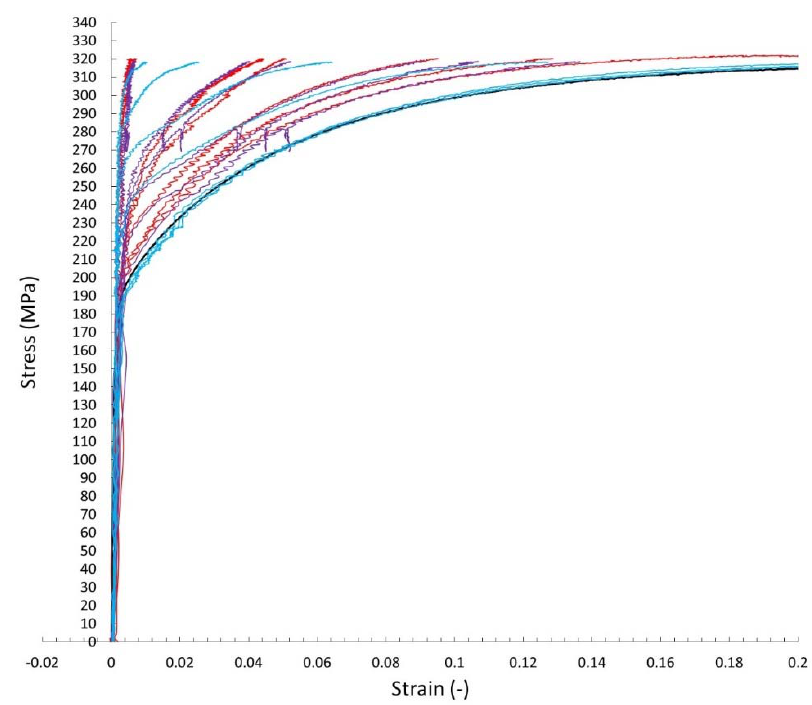
Figure 10. The curves of the static tensile test determined on the basis of the DIC method for welded joints made in robotic welding processes: brown—CMT solid wire; violet—CMT flux-cored wire; blue—laser welding without additional material; black—base material.